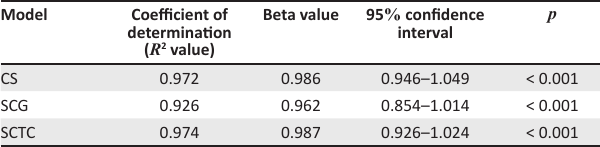
TABLE 3: Linear regression for plasma haemoglobin values determined by the plasma or low haemoglobin photometer and three alternative methods developed at the Quality Control Department of the National Blood Center, Sri Lanka, September 2020 – May 2021.